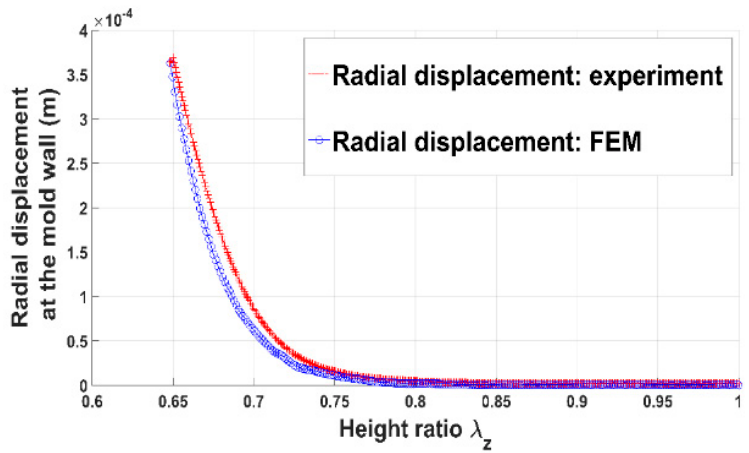
Materials 2019 , 12 , x FOR PEER REVIEW Figure 19. Circumferential strain at the mold wall: FEM vs. experiment. Figure 19. Circumferential strain at the mold wall: FEM vs. experiment. Figure 19. Circumferential strain at the mold wall: FEM vs. experiment.